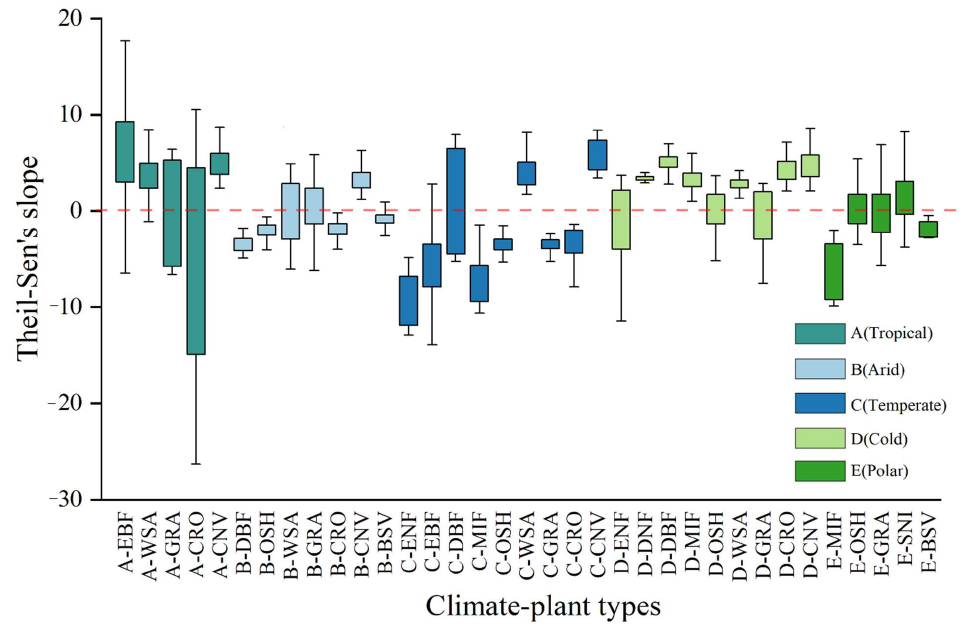
Figure 6. The Theil–Sen’s slope showing the confirmed trends in annual terrestrial water yield (WY) according to the climate-plant types, which are defined by Köppen-Geiger (KG) climate zones vs. IGBP land cover type (Table 1). The box plots show lower bound (=Q1 − 1.5 LQR), lower quartile (Q1), upper quartile (Q3) and upper bound (=Q3 + 1.5 LQR) from bottom to top, where LQR = Q3 − Q1.